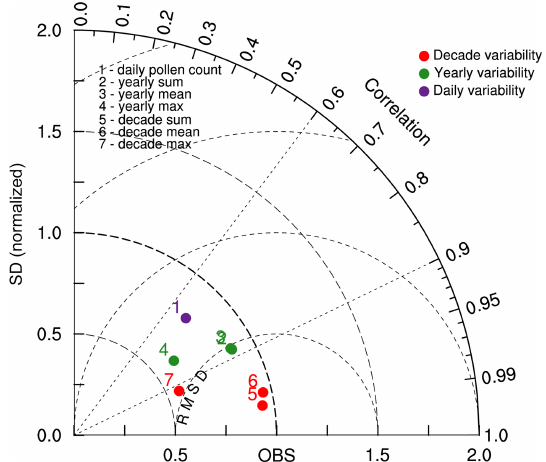
Figure 6. Normalized Taylor diagram showing spatial and temporal correlations coefficients, standard deviations and RMSEs between simulations and observations for the period 2000–2010. Standard deviation and RMSE are normalized by the standard deviation of observations at the relevant spatiotemporal